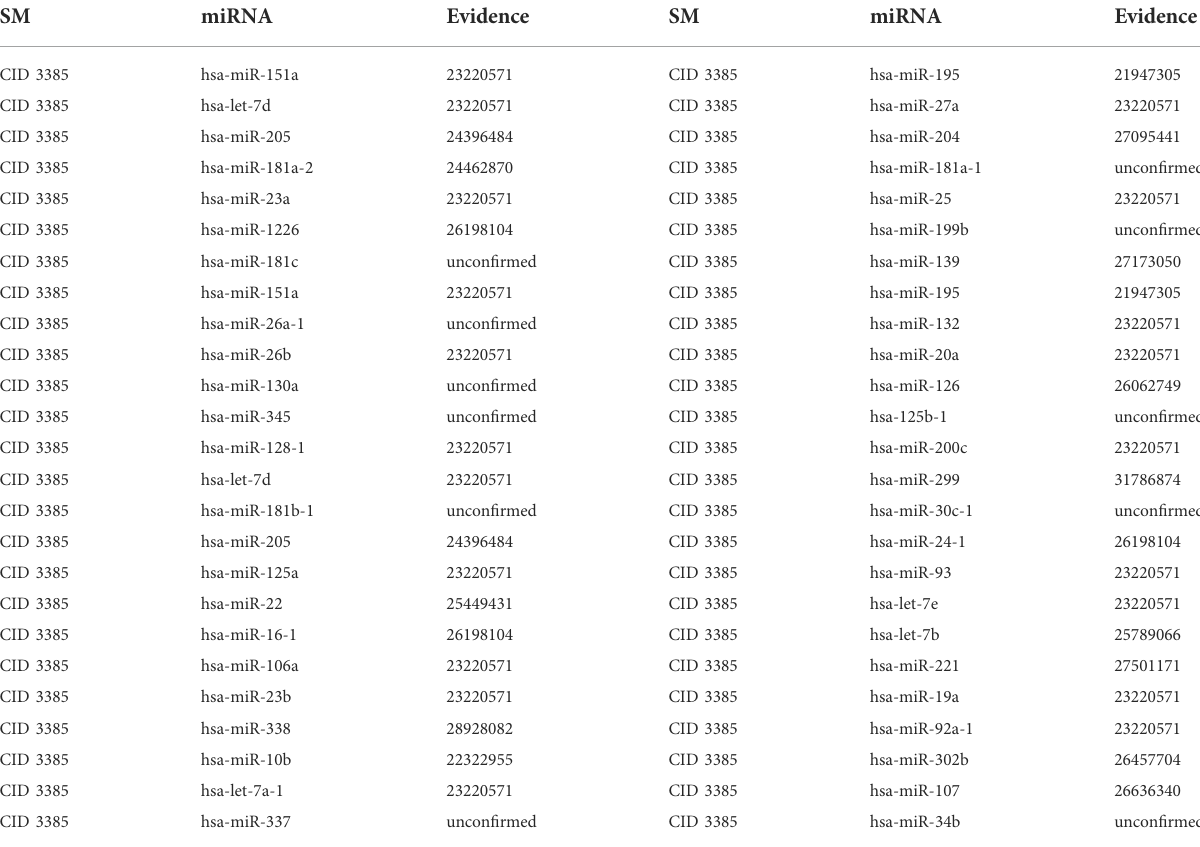
TABLE 4 Validation of the top 50 miRNAs associated with 5-Fu in the second type of case studies. The fi rst column records the top 1 – 25 related miRNAs. The second column records the top 26 – 50 related miRNAs.